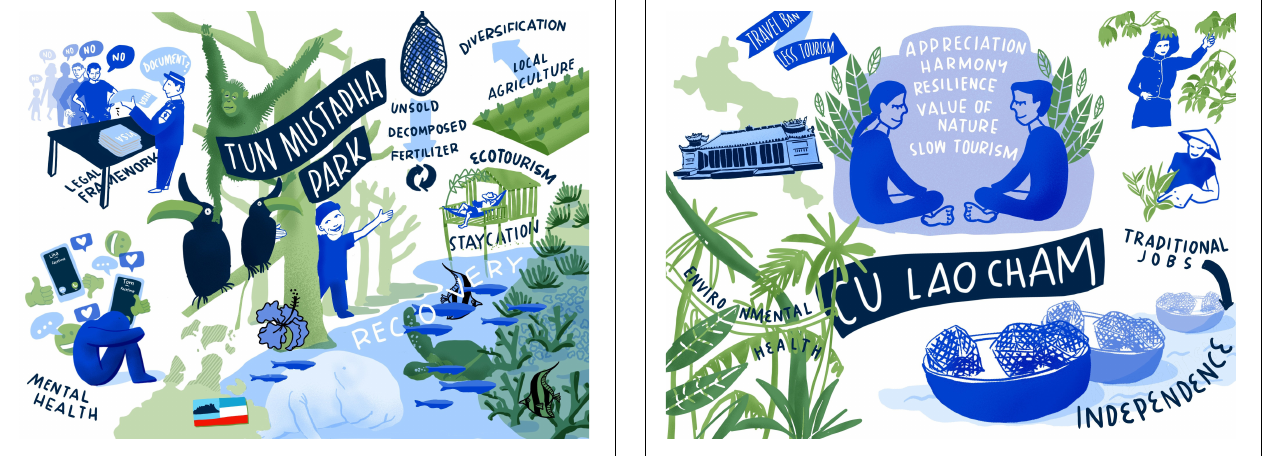
FIGURE 2 | COVID-19 scenario for Tun Mustapha Park. Illustration by Lina Ernst Illustrations.